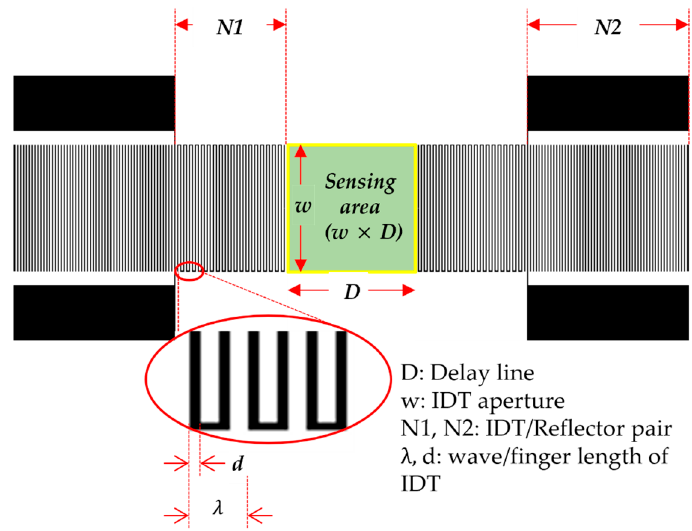
Figure 2. SAW sensor design and